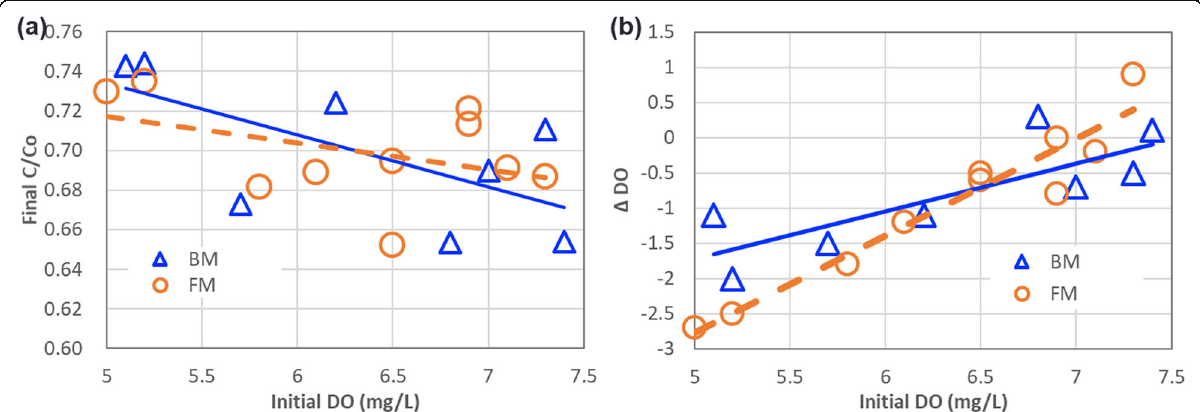
Fig. 7 Magnetic field-affected photocatalytic degradation of MO under the application of BM and FM with various concentration of dissolved oxygen. a Final C/Co and b difference on (used) dissolved oxygen before and after